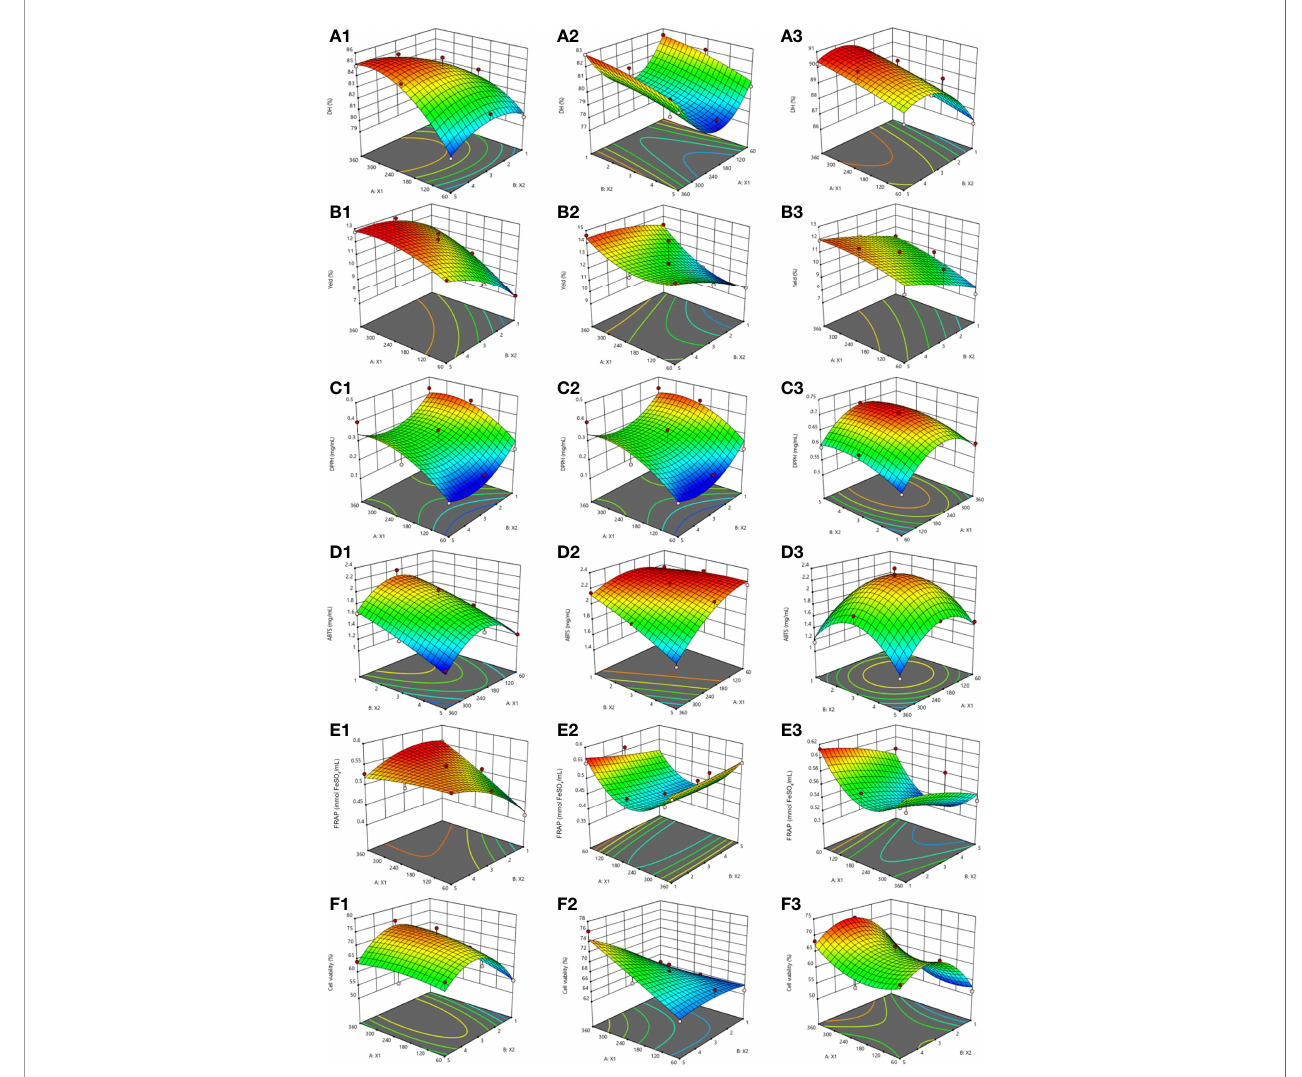
FIGURE 2 | The 3D and contour plots of hydrolysis time (X 1 : min) against the concentration of papain (A1-F1) , alcalase (A2-F2) , and fl avourzyme (A3-F3) (X 2 ; %) for the degree of hydrolysis (%DH), yield (%), IC 50 of DPPH radical scavenging activity (mg/mL), IC 50 of ABTS radical scavenging activity (mg/mL), FRAP value (mmol FeSO 4 /mL), and UV-B protective activity express as the cell viability